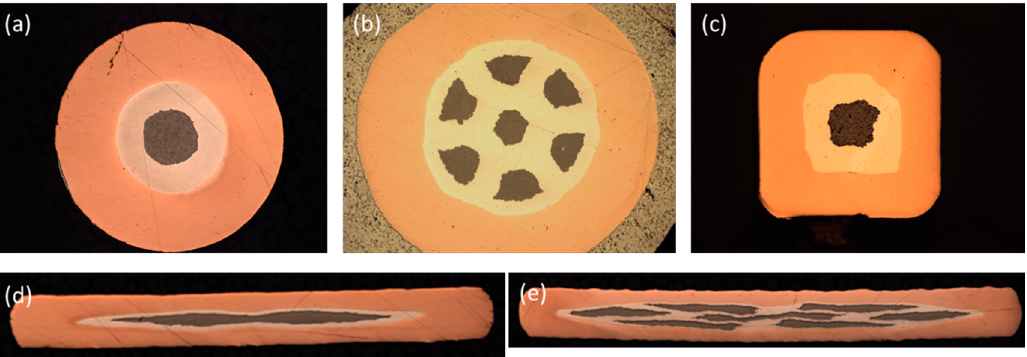
Figure 10. The cross sections of (Ba,K)Fe 2 As 2 ( a ) round wire, ( b ) round seven-filament wire, ( c ) square wire, ( d ) tape, and ( e ) seven-filament tape. ( c ) square wire, ( d ) tape, and ( e ) seven-filament